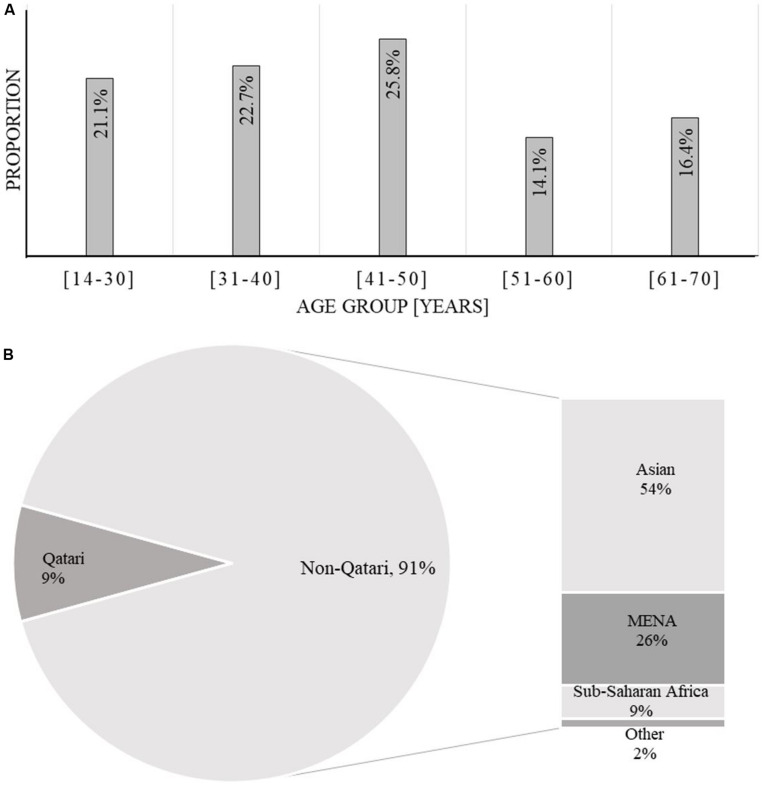
Cohort demographics by age (A) and origin (B). Gender ratio (M/F) = 2.76.